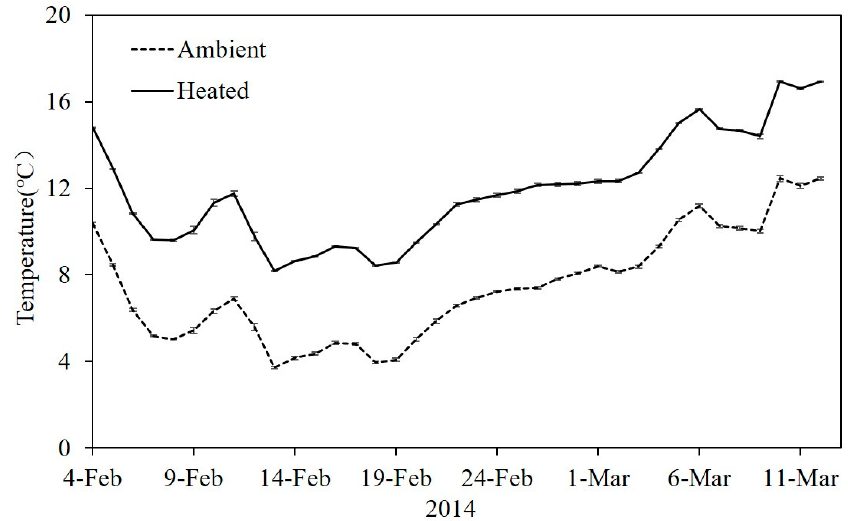
Figure 1. Mean daily temperature in the ambient and heated tanks during the experimental period (n = 6 per treatment) in 2014. Data are means ± standard error (SE).